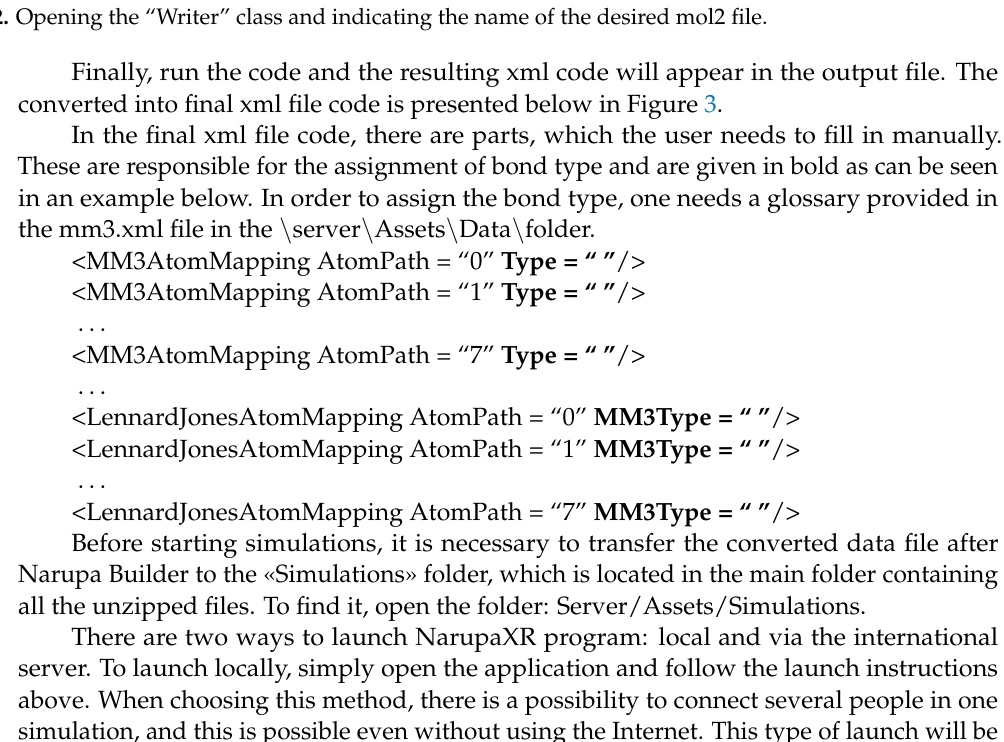
Figure 2. Opening the “Writer” class and indicating the name of the desired mol2 file. Finally, run the code and the resulting xml code will appear in the output file. The converted into final xml file code is presented below in Figure 3.